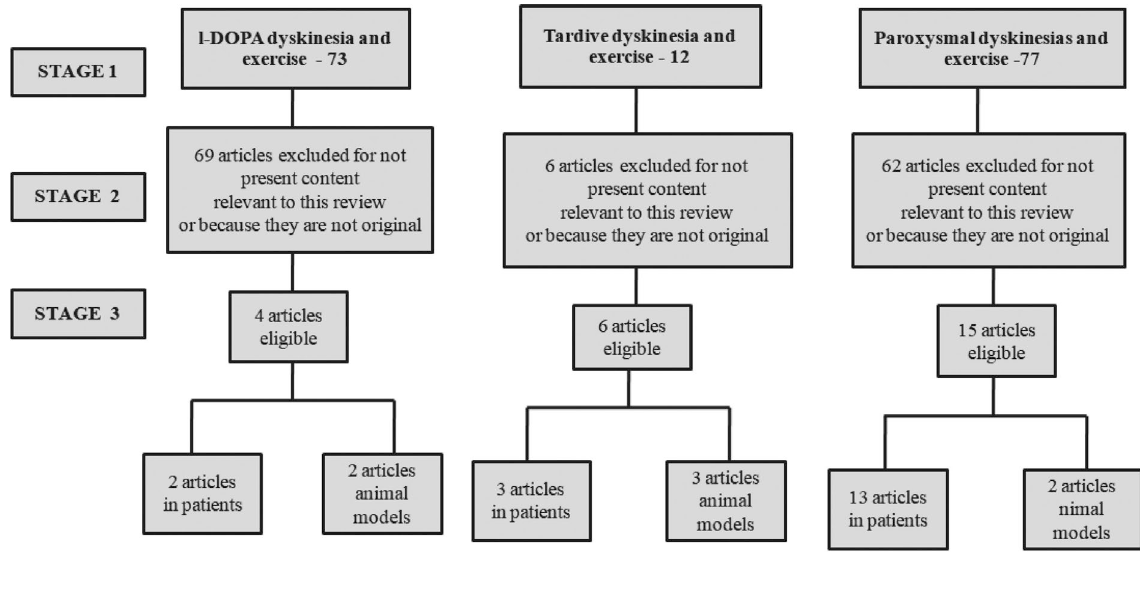
Figure 1 - Flow diagram of the selection